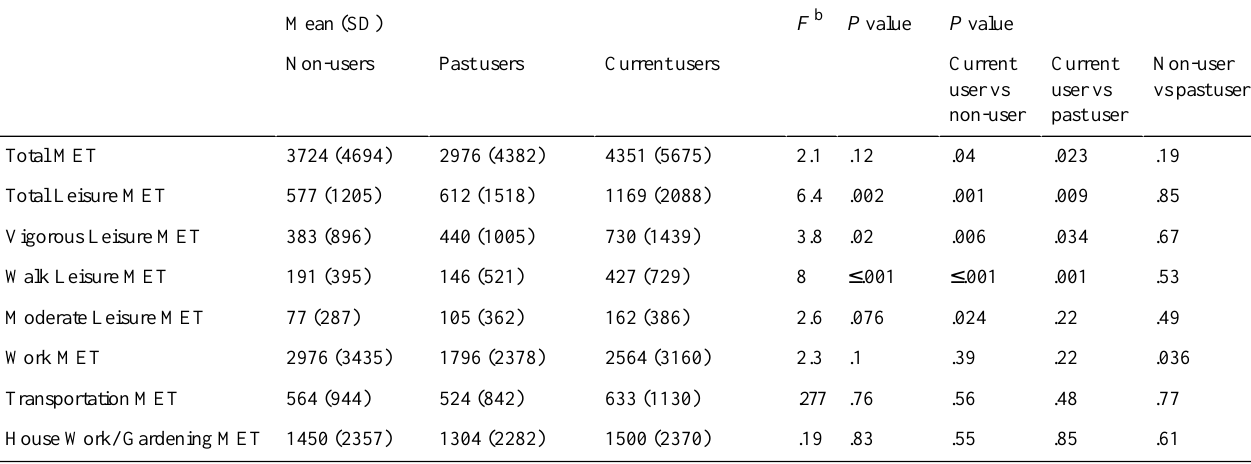
Table 3. MET comparisons across app use groups.